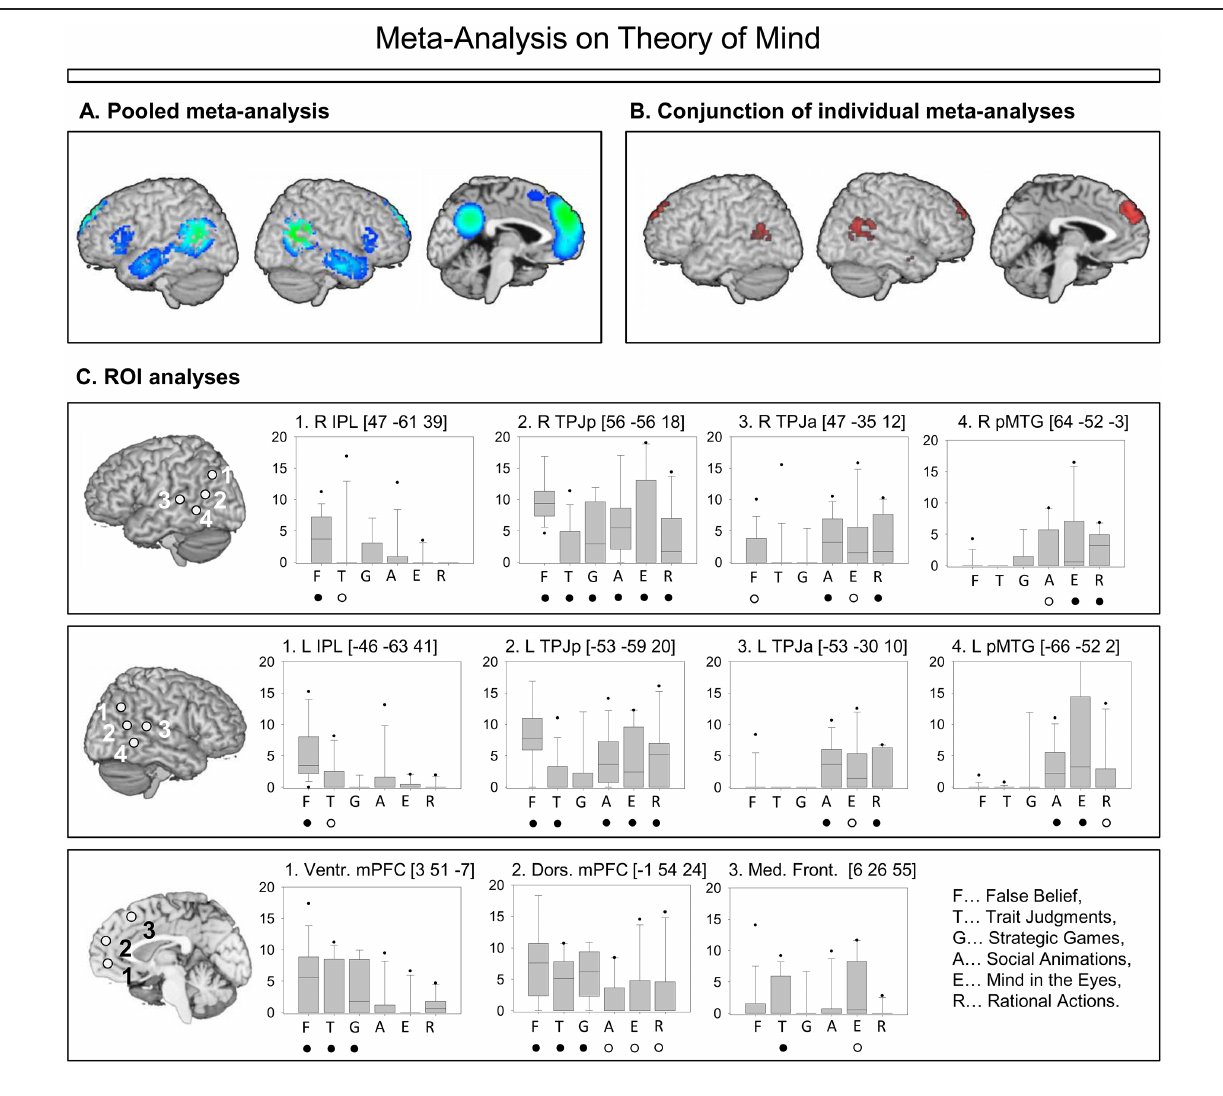
FIGURE 1 | Summary of the results in Schurz et al. (2014). (A) Pooled meta-analysis on Theory of Mind (ToM) across all task-groups. Colors represent probability values from statistical permutation testing ( z -values). (B) Conjunction of six meta-analyses, statistically powerful permutation-based overlap analysis (for details, see Schurz et al., 2014). Maps were thresholded at voxel-wise threshold of p < 0.005 uncorrected and a cluster extent threshold 10 voxels. (C) Regions of interest in posterior temporo-parietal and medial prefrontal areas. Box-plots (median; 25 and 75th percentiles; 5 and 95th percentiles) show the distributions of effect-sizes for the studies in each group. Effect-sizes were weighted by intra-study variances. Significant convergence of effect-sizes above zero was determined by randomization tests; full circles indicate p < 0.005 uncorrected, z > 1. Empty circles indicate p < 0.05, z >